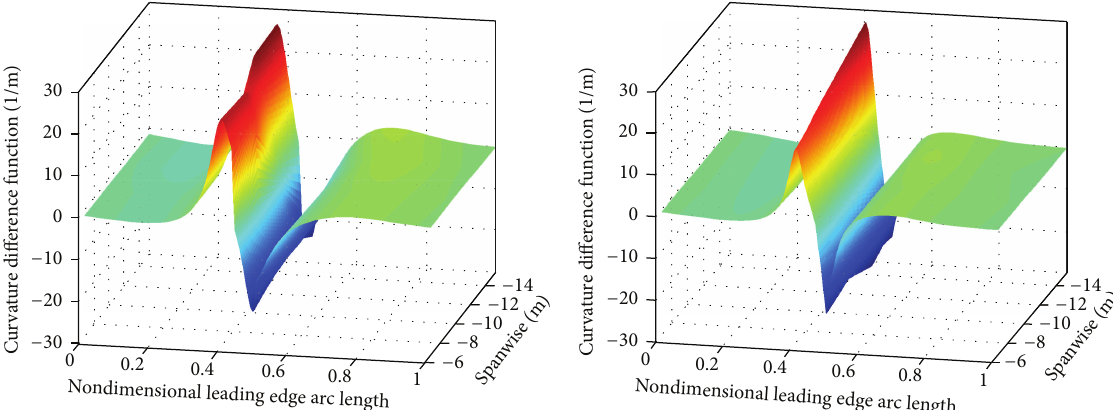
Figure 16: Curvature difference functions along the wing span for 10 % and 20 % chordwise maximum droop